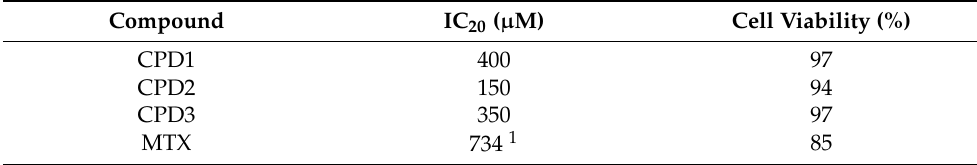
Table 1. Cell growth inhibition concentration (IC 20 ) and cell viability at the IC 20 for each tested